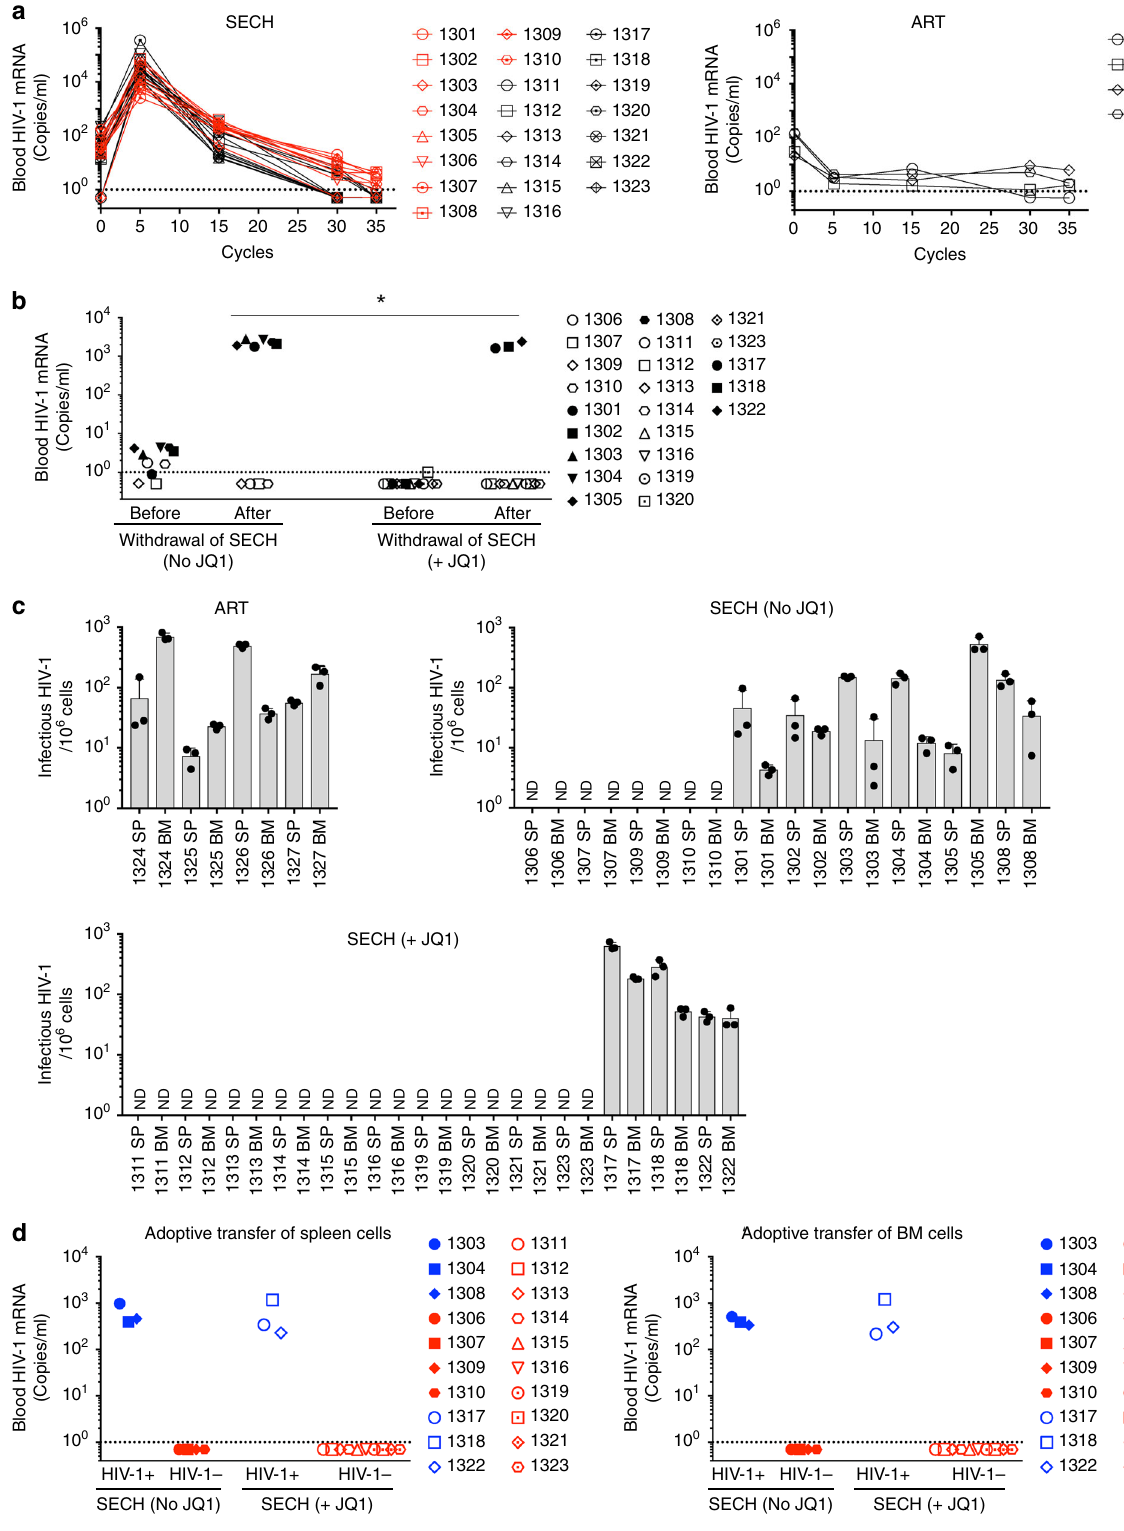
Fig. 5 Improvement of SECH treatment by inclusion of JQ1. a Viral RNA levels in one set of HIV-1-infected Hu-HSC mice (Supplementary Table 3) orally treated by SECH with (black symbols) or without JQ1 (red symbols) for a total of 35 cycles (ART, n = 5 mice; SECH, n = 10 mice; SECH + JQ1, n = 13 mice). The dash line indicates detection limit. b Viral titer in the blood before and after withdrawal of the treatments. (SECH, n = 10 mice; SECH + JQ1, n = 13 mice). No JQ1 vs. JQ1, p = 0.0407 (Mann – Whitney test). c Measuring infectious HIV-1 from spleen and bone marrow cells of HIV-1-infected Hu-HSC mice by TZA. Biological samples from each mouse were measured in three technical replicates. Data are presented as mean ± SD (ART, n = 5 mice; SECH, n = 10 mice; SECH + JQ1, n = 13 mice). ND, not detectable. d hmVOA for spleen and bone marrow cells from mice in c (SECH, n = 7 mice; SECH + JQ1, n = 13 mice). Source data are provided as a Source Data fi